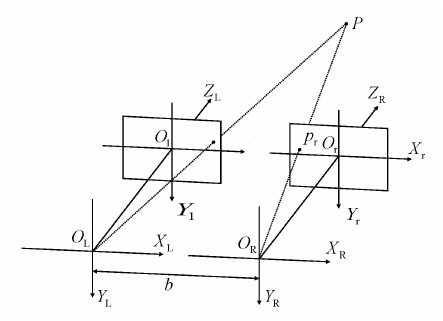
Figure 7. The schematic diagram of ideal binocular stereo